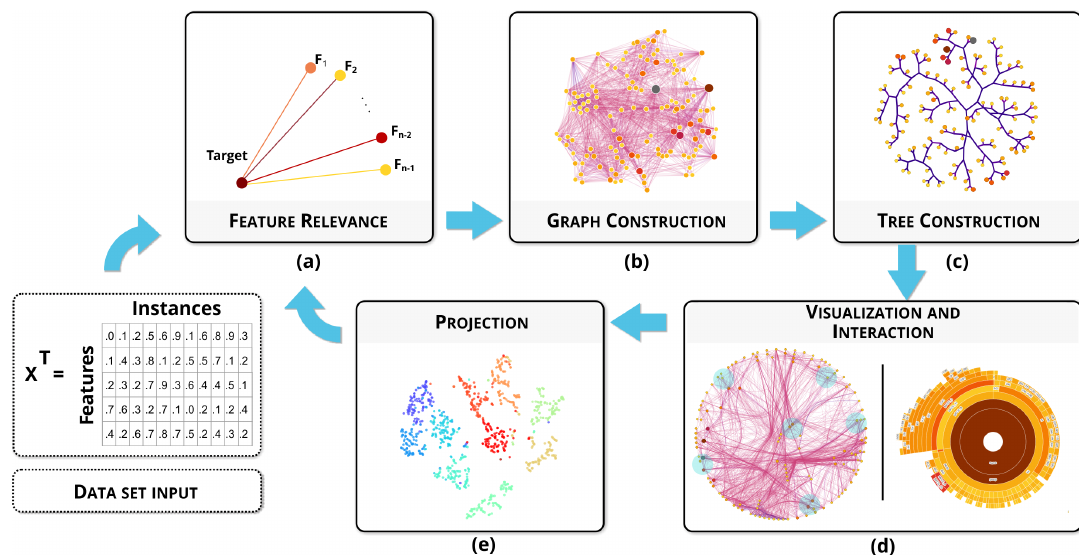
Figure 1. Analysis pipeline of Graphs from Features (GFF). From a dataset X with n data instances having d features each, ( a ) a proximity measure between pairs of features is evaluated, and ( b )